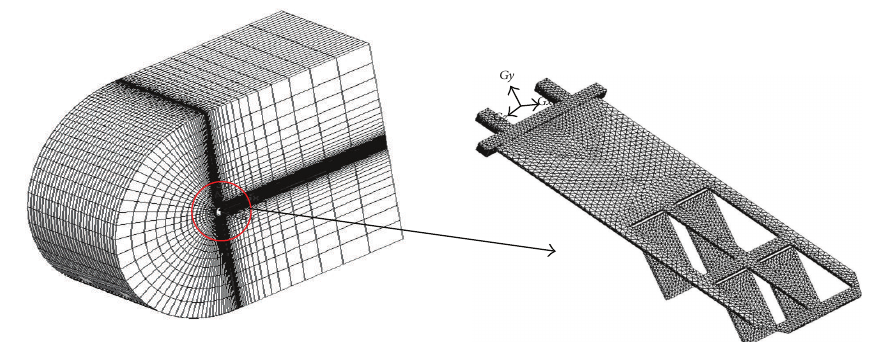
Figure 4: Decomposition of the computational